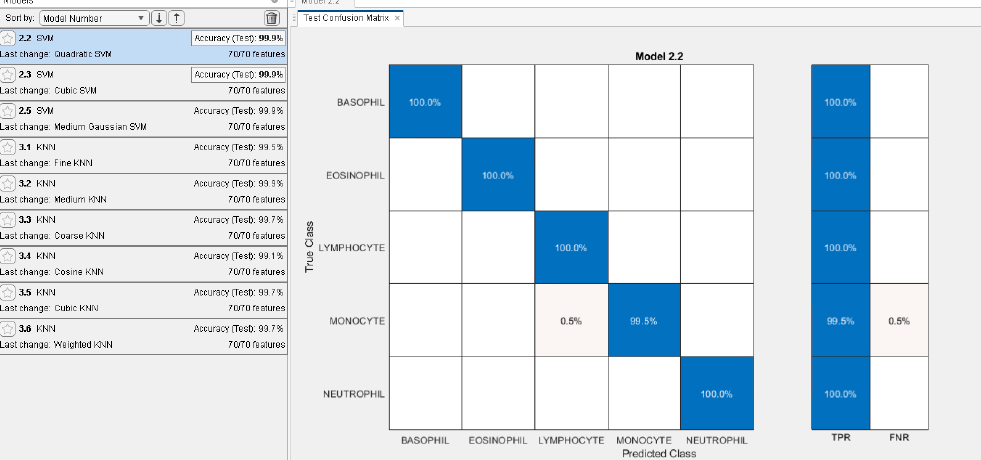
Figure 6. Classification results of proposed WBCs classification system. Left: Test accuracy achieved by SVM and KNN classifiers with several kernels. Right: Confusion matrix of SVM with quadratic